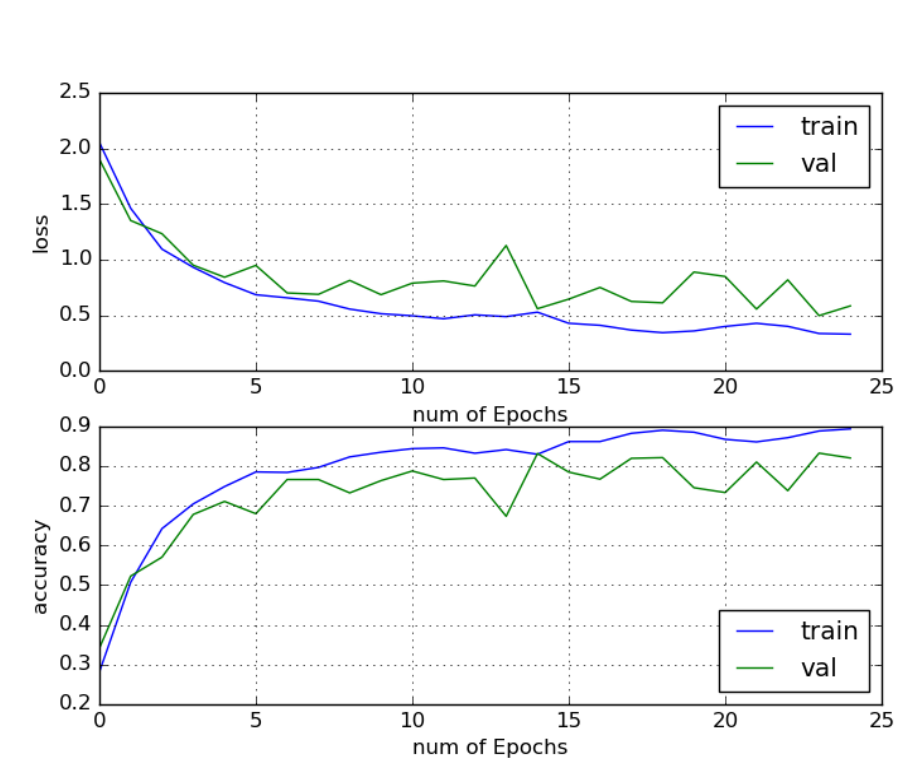
Figure 2. VGG-16 fine tune model on CVSI-15 using SGD optimizer.